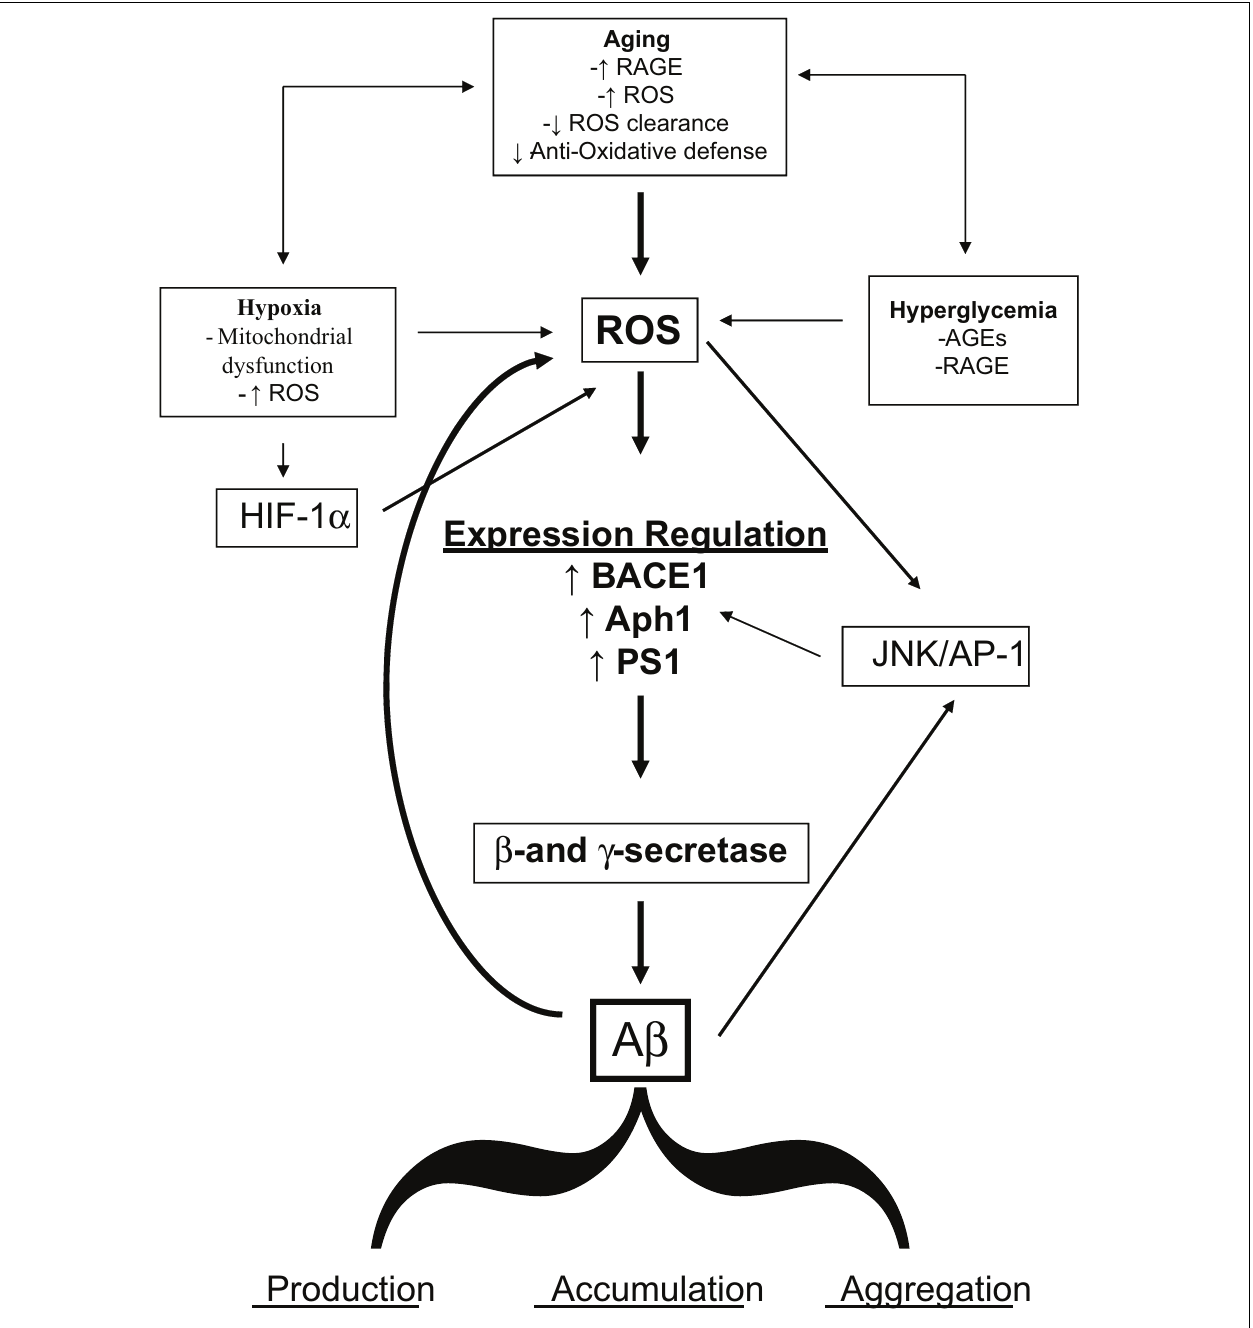
FIGURE 1 | Diagram sketching upstream mediators and downstream consequences of oxidative stress in sporadic